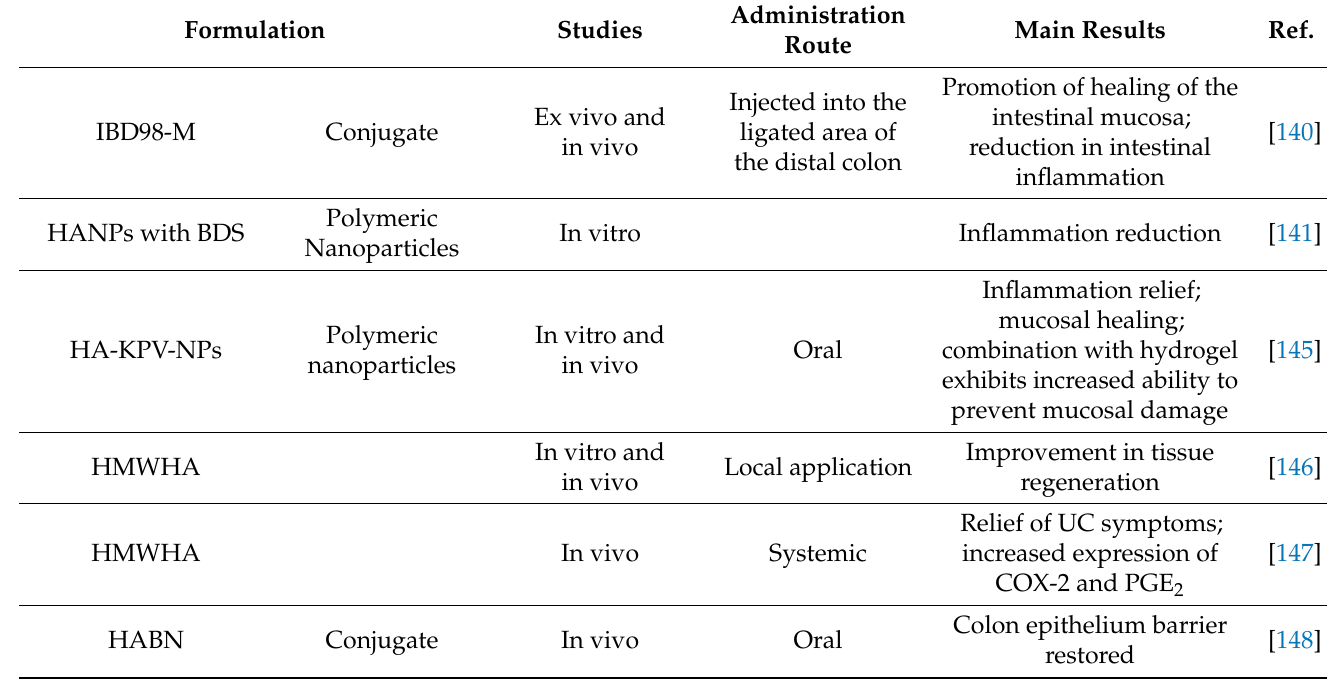
Table 4. Study summaries using with HA for the treatment of inflammatory bowel